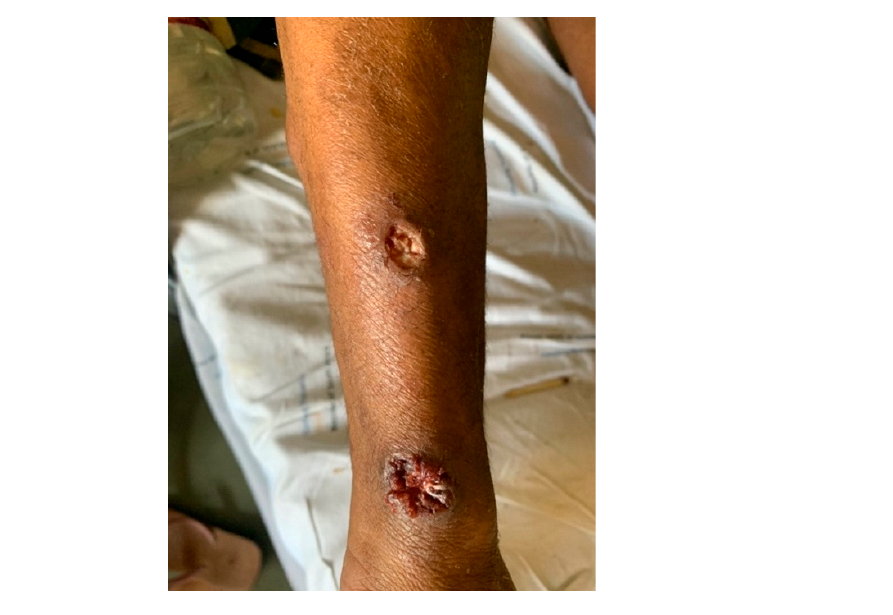
Figure 3. Patient’s right forearm, showing skin ulcers originating from dermal nodules.